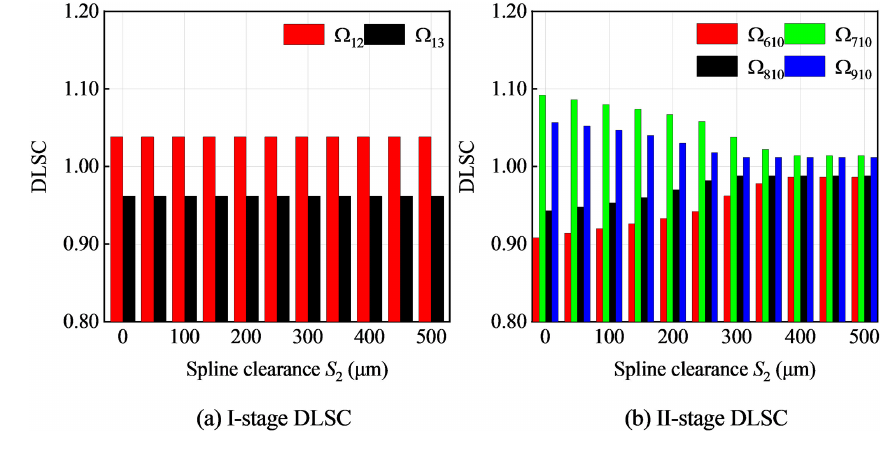
Figure 15. Load-sharing coefficient changed with the spline clearance.